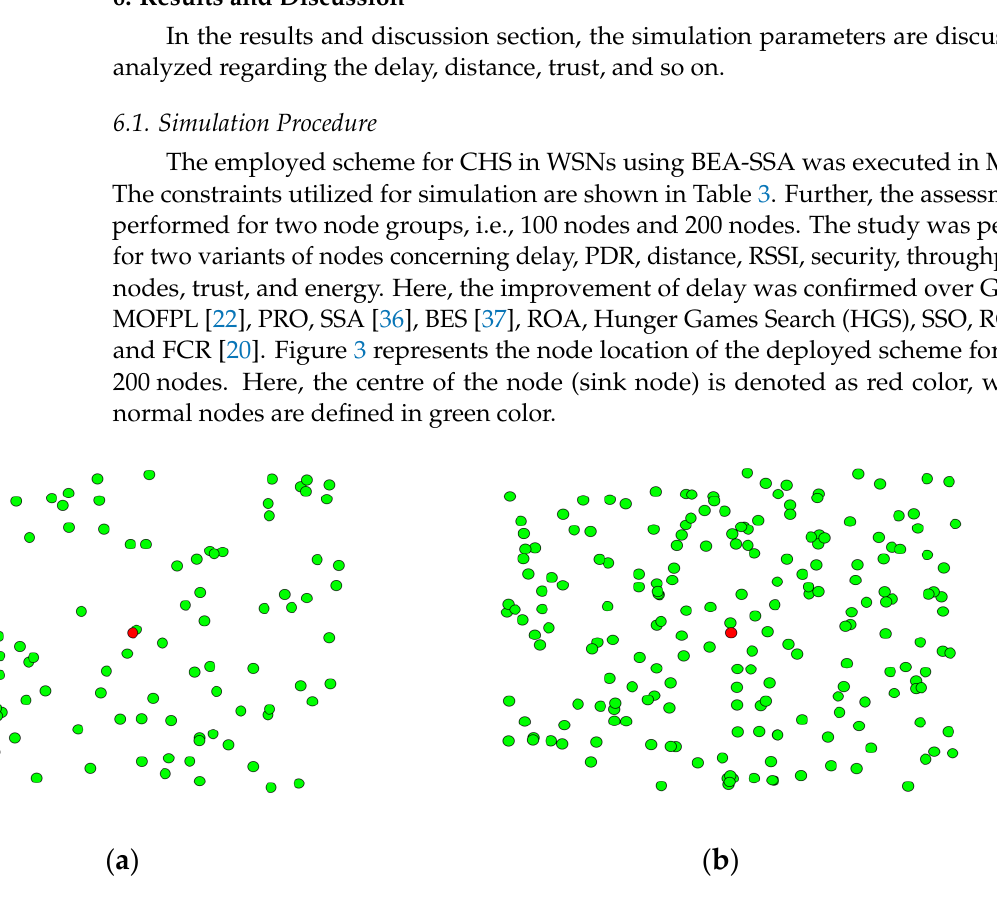
Table 3. Simulation Parameters.